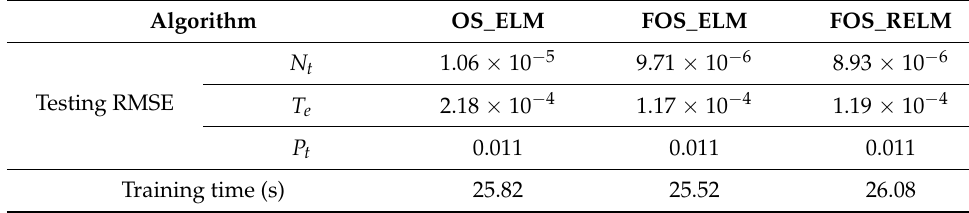
Table 3. Identification effects of FOS_RELM, FOS_ELM, and OS_ELM algorithms.